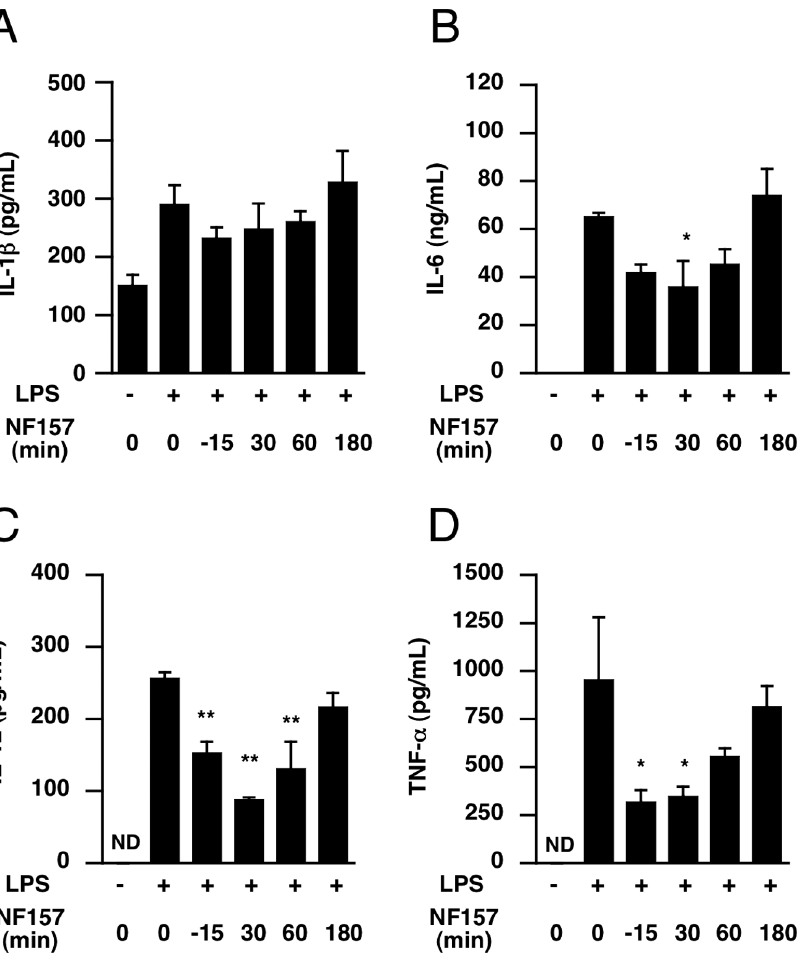
Figure 11. Suppressive effect of post-treatment with NF157 on serum levels of cytokines in LPS-treated mice. ( A – D ) Male C57BL/6 mice at 6 weeks of age were given LPS (400 m g/head i.p.). Treatment with NF157 was initiated 15 min before to 180 min after the onset of LPS injection. Blood samples were collected at 6 h after LPS injection. Serum levels of IL-1ß, IL-6, IL-12 and TNF-alpha were determined as described in Materials and Methods . Each value represents the mean 6 SE (n=4). Significant differences between a test group and control group (LPS alone) are indicated by *(p , 0.05) and **(p , 0.01), respectively.